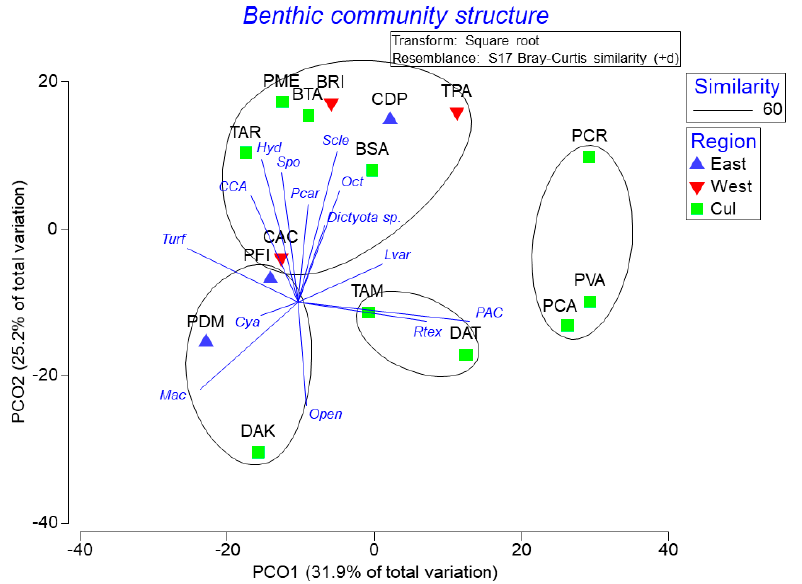
Figure 3. Spatial variation pattern in coral reef benthic community structure. This solution explained 57.1% of the observed spatial variation. Refer to the Methodology for the description of acronyms.